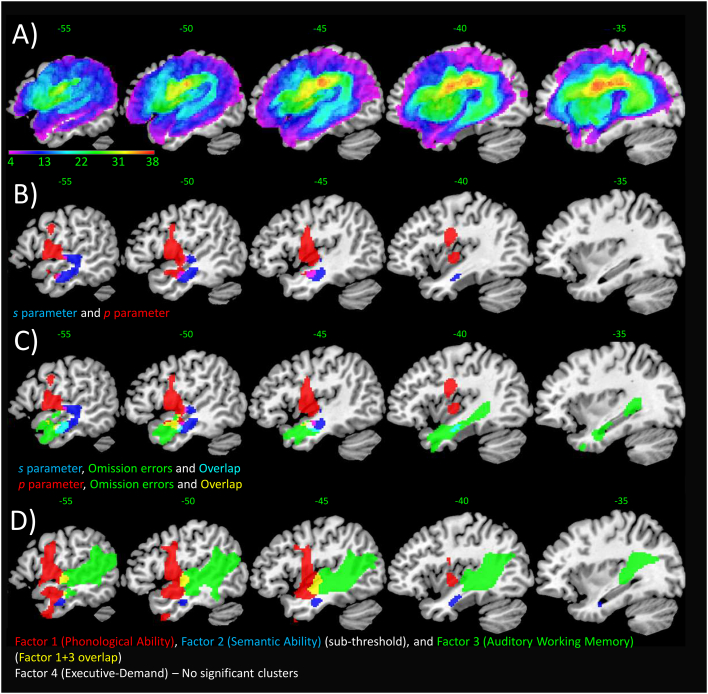
(A) Lesion overlap map across PWA in the current study. Maximum voxel = 38 (x, y, z: −21, −11, 26), located in the left superior corona radiata white matter. (B) VBCM analysis for s parameter weight (blue) and p parameter weight (red) (voxel height p < 0.005, FWE-cluster corrected p < 0.05). (C) VBCM analysis for s and p parameter weights, omission errors, and their overlap (voxel height threshold p = 0.005, FWE-cluster corrected p < 0.05). (D) VBCM correlations on factors from omnibus principal component analysis. Significant clusters are colour coded according to legend and thresholded at p = 0.005 voxel height, FWE-cluster corrected p < 0.05 (except blue cluster in D) which is at p = 0.005 voxel height uncorrected, 244 voxels). All results corrected for age, education and lesion volume; see Supplementary Table S4 for details on peak coordinates and anatomy. (For interpretation of the references to colour in this figure legend, the reader is referred to the web version of this article.)